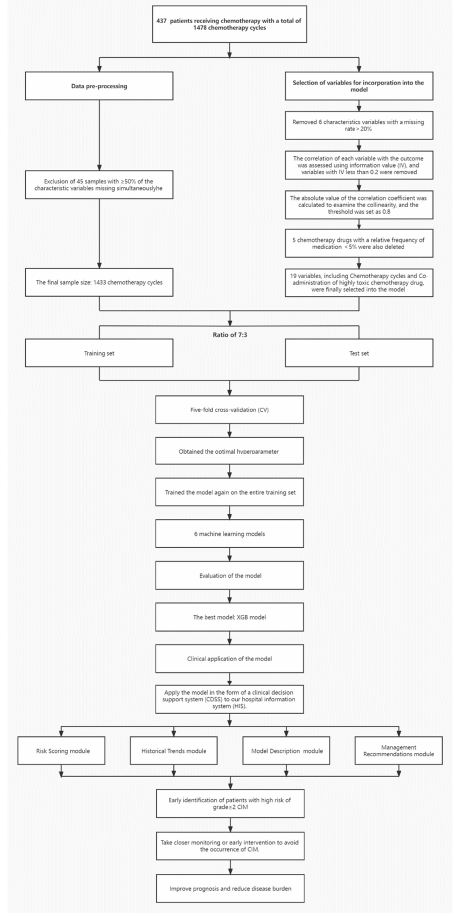
Figure 1. The entire modeling procedure.